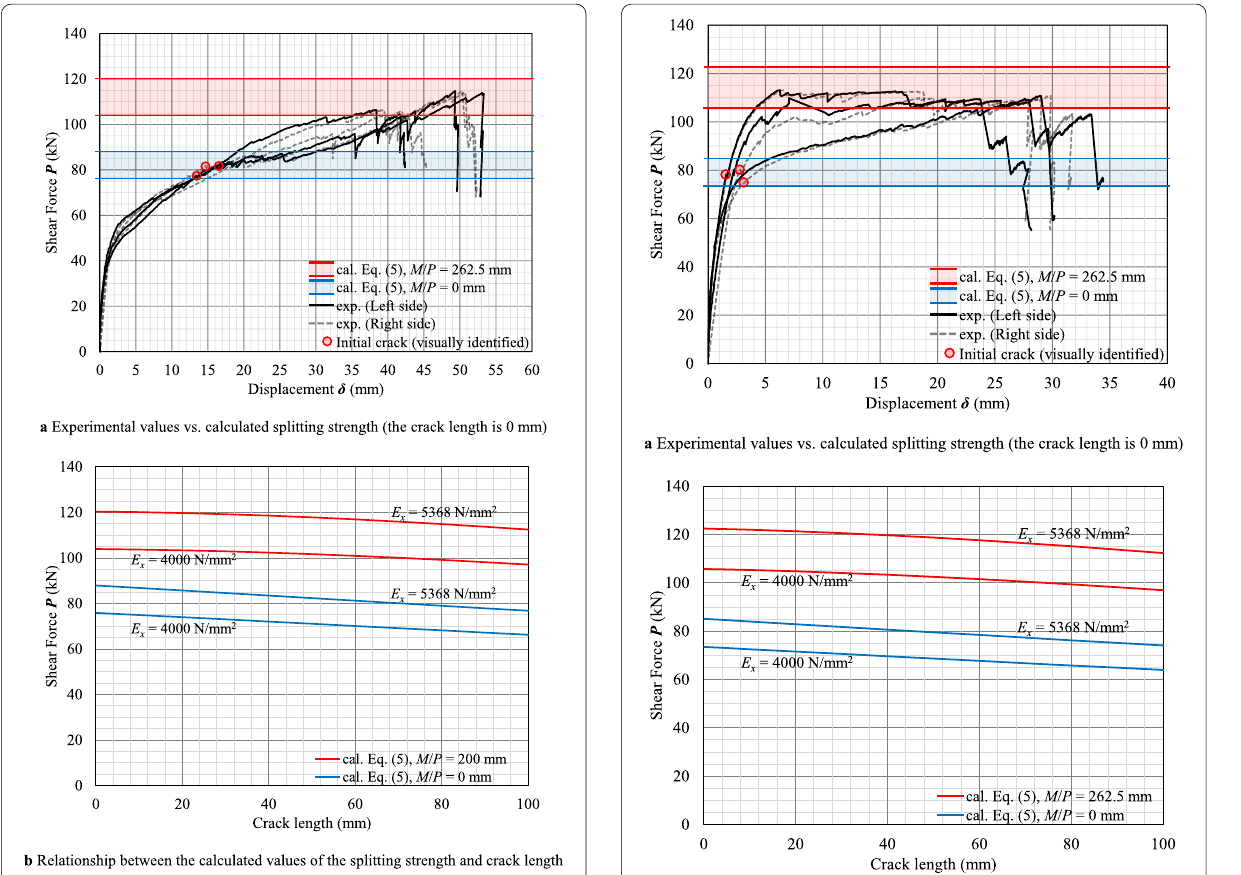
Fig. 26 Calculated value of the splitting strength for J-L100